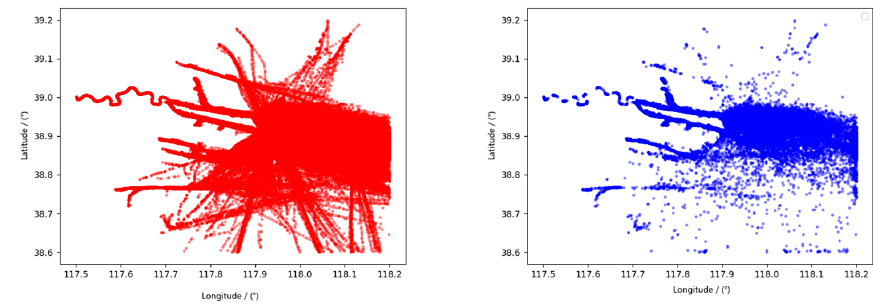
Figure 14. AIS trajectory pre-processing effect in Tianjin Port.